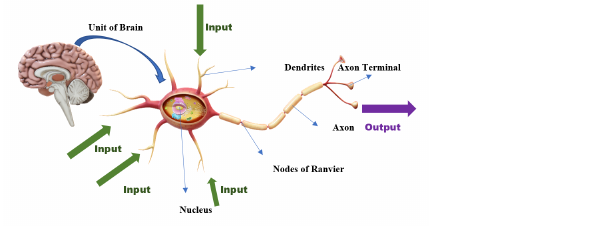
Figure 1. Structure of Neuron. Singnals are recieved by dendrites and passed in the form of outpout by axon.